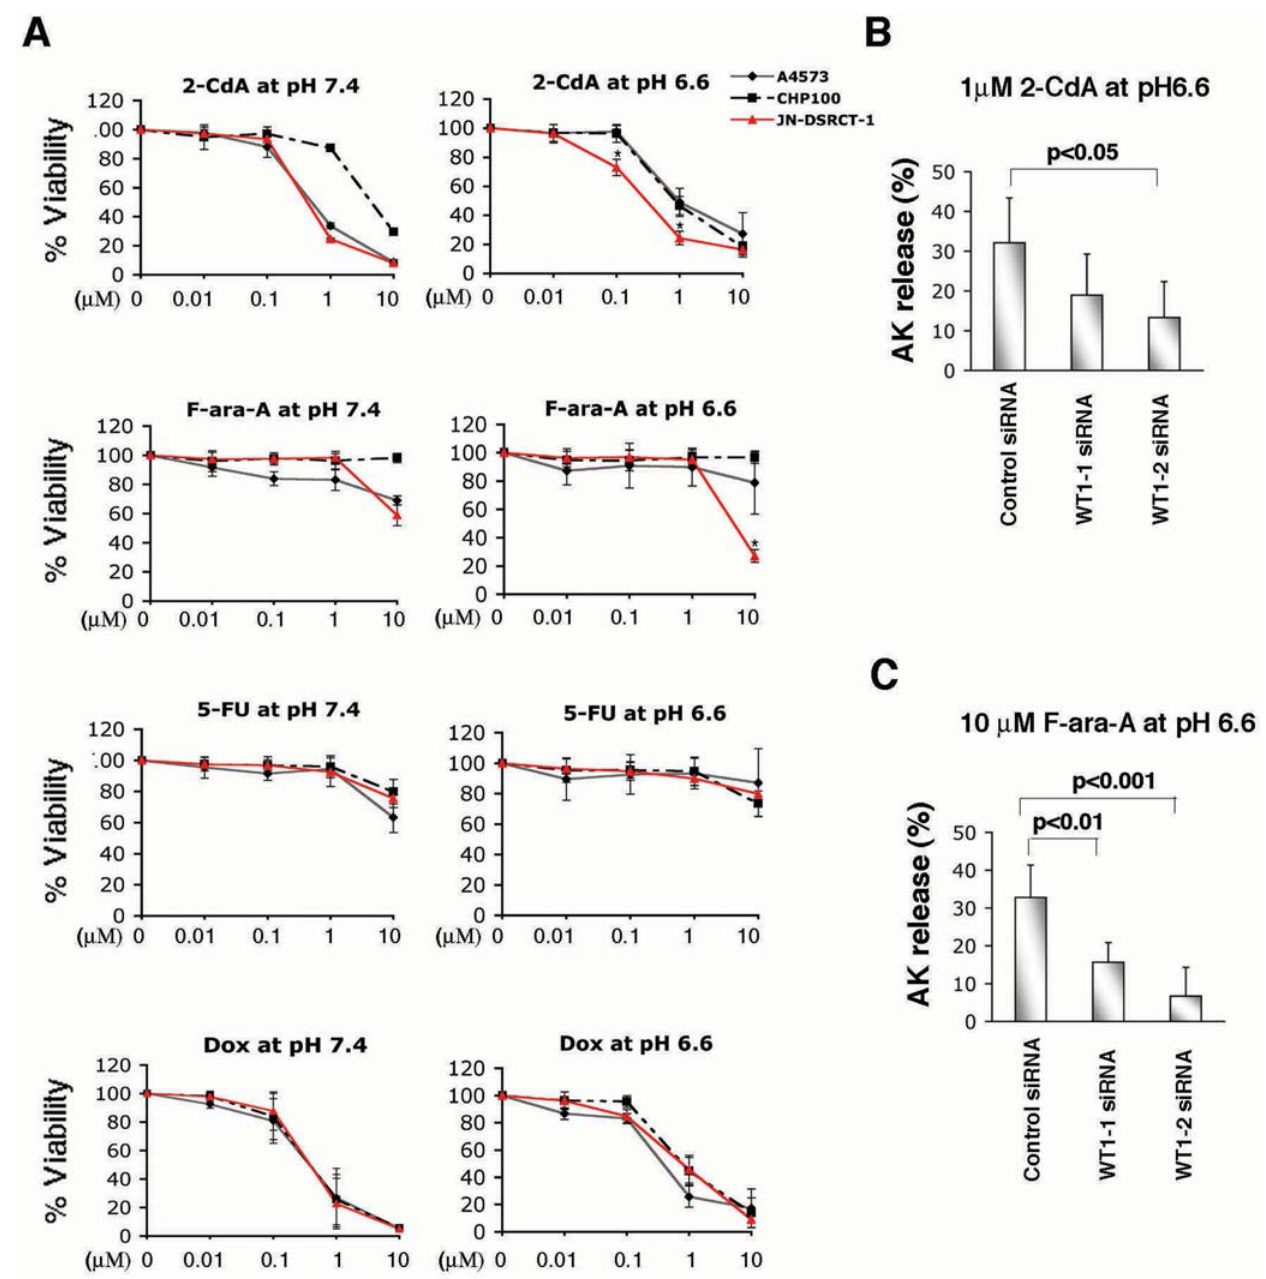
Figure 5. JN-DSRCT-1 cells display dose- and pH-dependent cytotoxicity to adenosine analogs. A. Cytotoxic assay. JN-DSRCT-1, A4573, and CHP100 cells were exposed to various concentrations (0.01–10 m M) of 2-CdA, F-ara-A, 5-FU or doxorubicin (Dox) for 72 hrs at pH 7.4 or pH 6.6. Cell viability was determined with Cell Counting Kit-8 (Dojindo Molecular Technologies). Data represent the mean 6 S.D. from three independent experiments performed in duplicate. *, p value , 0.01 was calculated by first performing one-way ANOVA analysis followed by Tukey’s multiple comparison test. B and C. JN-DSRCT-1 cells were transfected with either control, WT1-1 or WT1-2 siRNAs using Lipofectamine TM 2000 for 24 hrs, and the cells were treated with either 1 m M of 2-CdA (B) or 10 m M of F-ara-A (C) at pH 6.6 for 48 hrs. The knockdown efficiency of ENT4 was confirmed by qRT-PCR (as in Fig. 4C) and cytotoxicity was assessed by Toxilight BioAssay Kit (see Materials and Methods). Data represent the mean 6 S.D. from at least three independent experiments performed in duplicate. p value was calculated by first performing one-way ANOVA analysis followed by Tukey’s multiple comparison test.